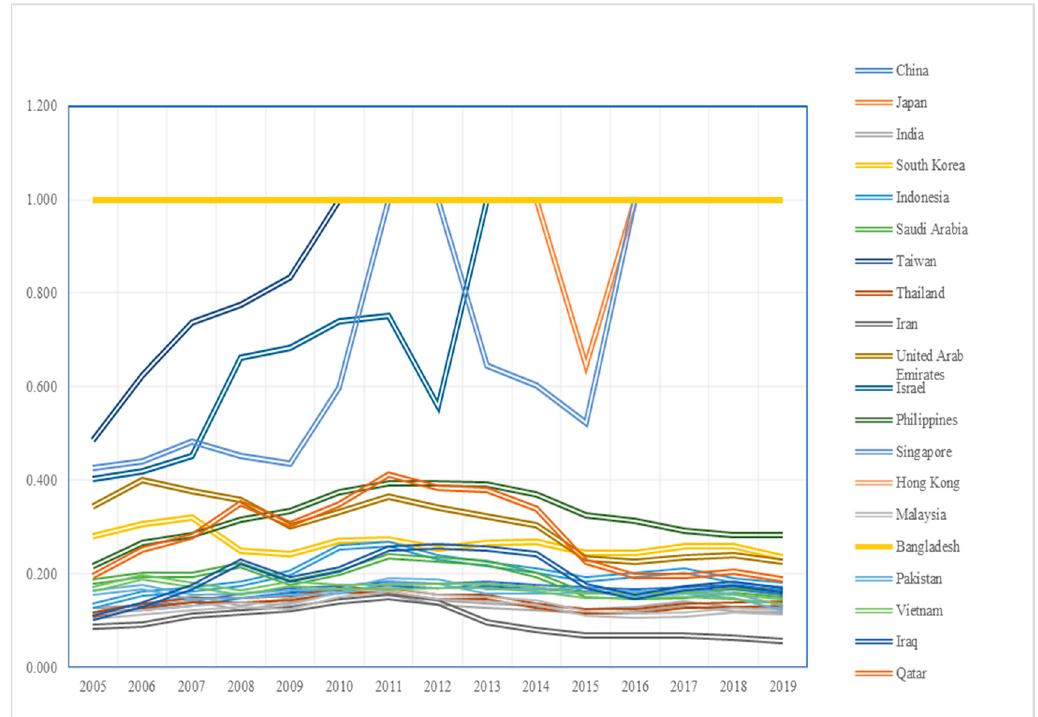
Figure 2. Changes in environmental efficiency score among countries in 2005–2019. Source: authors’ estimation.